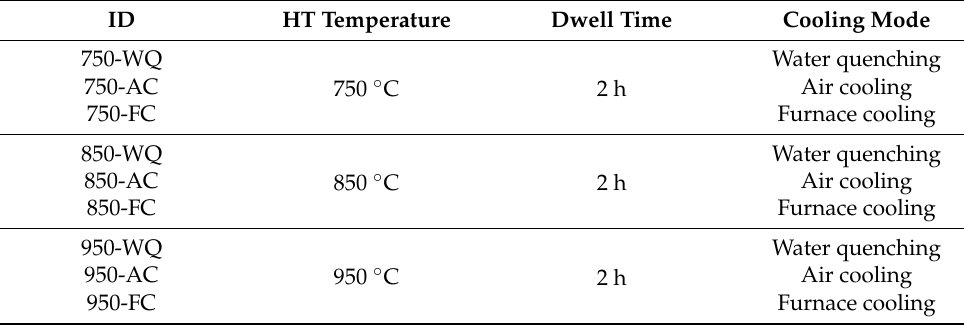
Table 2. Details of post-heat treatments.